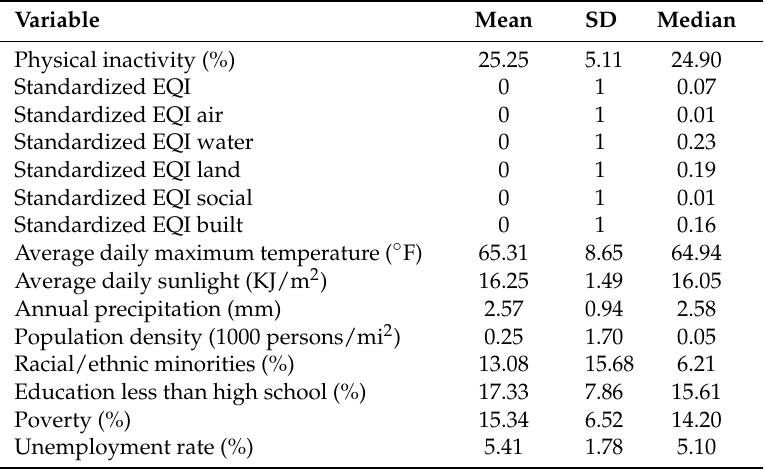
Table 1. Summary statistics of U.S.